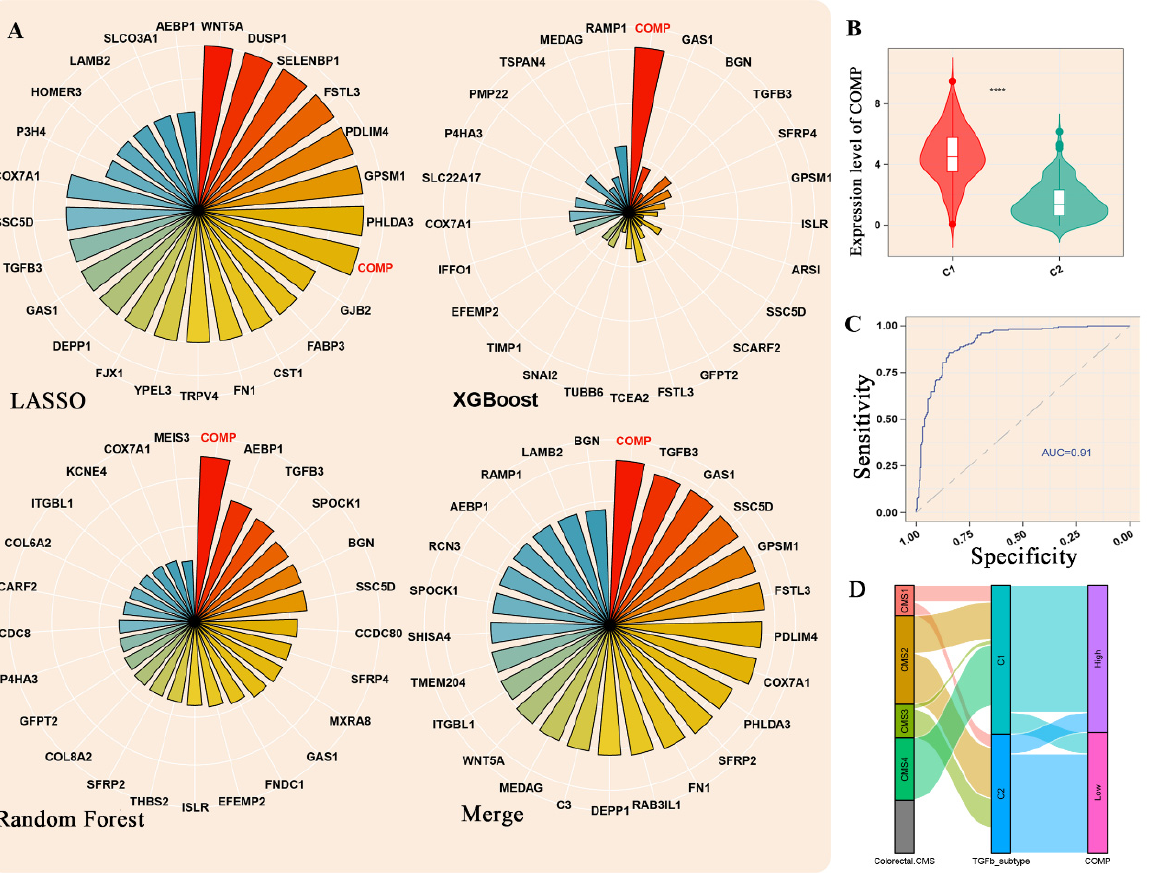
Figure 3. Identification of the hub gene mediating the differences between C1 and C2 subtypes. ( A ) LASSO, XGBoost, random forest, and an integrated algorithm were performed to explore the most important hub gene. ( B ) The expression level of COMP, the hub gene, between two groups. **** P < 0.0001. ( C ) ROC exhibited an excellent classification role of COMP for C1 and C2, with AUC equaling 0.91. ( D ) The Sankey diagram shows the relationship between CMS, TGF- β subtype, and COMP expression level.